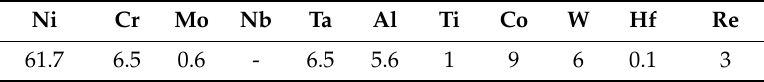
Table 1. Chemical composition of the CMSX 4 superalloy, wt